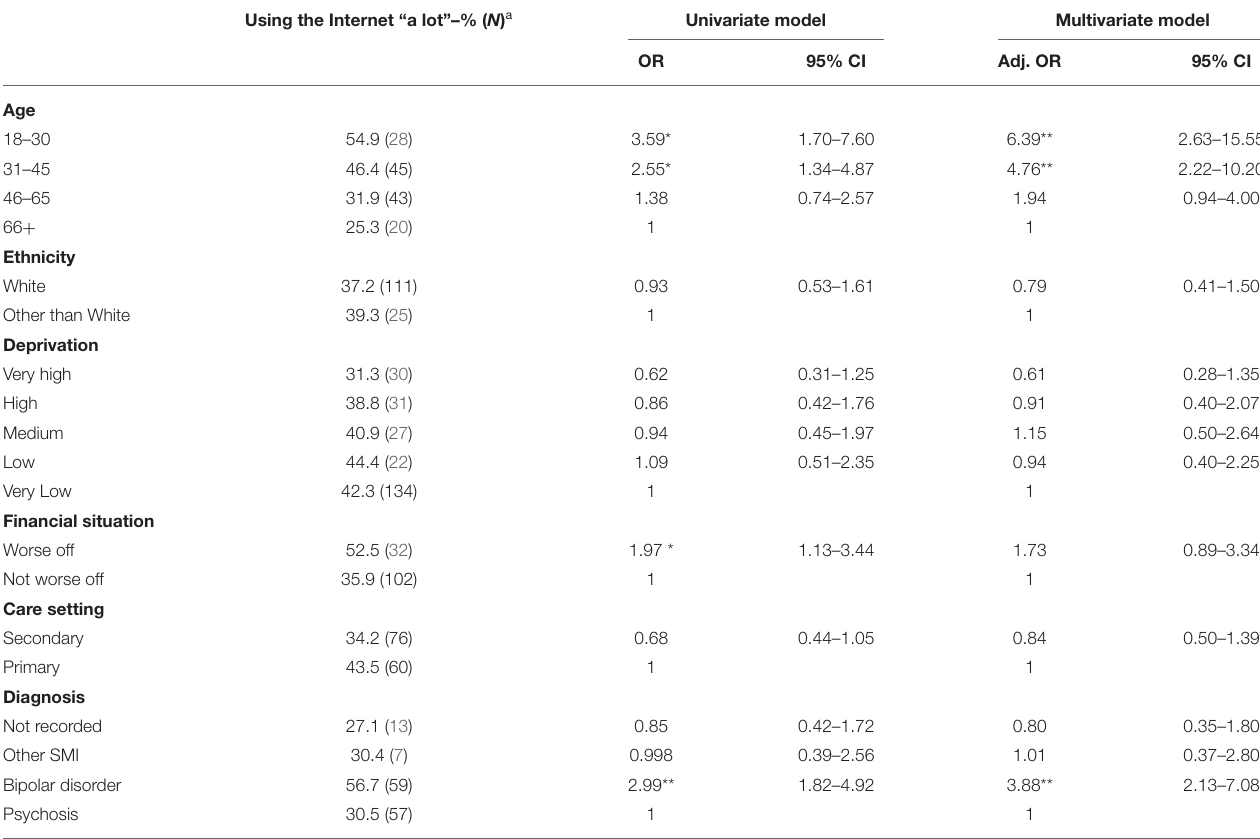
TABLE 3 | Sample characteristics associated with Internet use. Using the Internet “a lot”–% ( N )